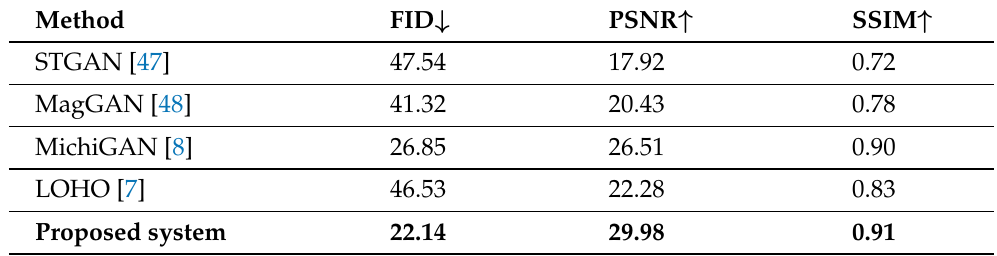
Table 1. The comparison of proposed work against various techniques using FID, PSNR, and SSIM